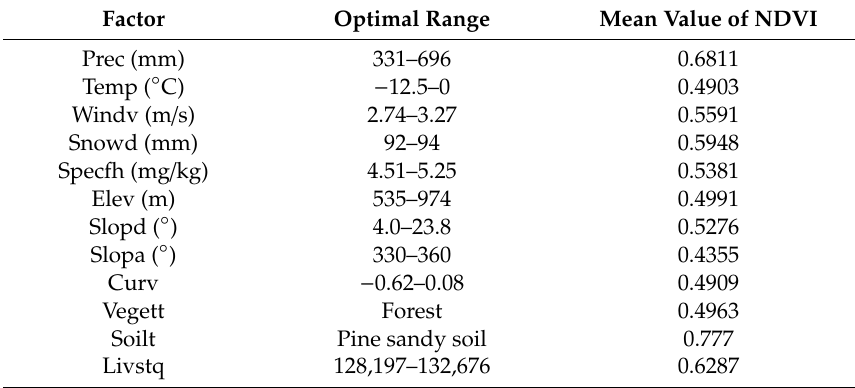
Table 5. The optimal range of each environmental factors with maximum